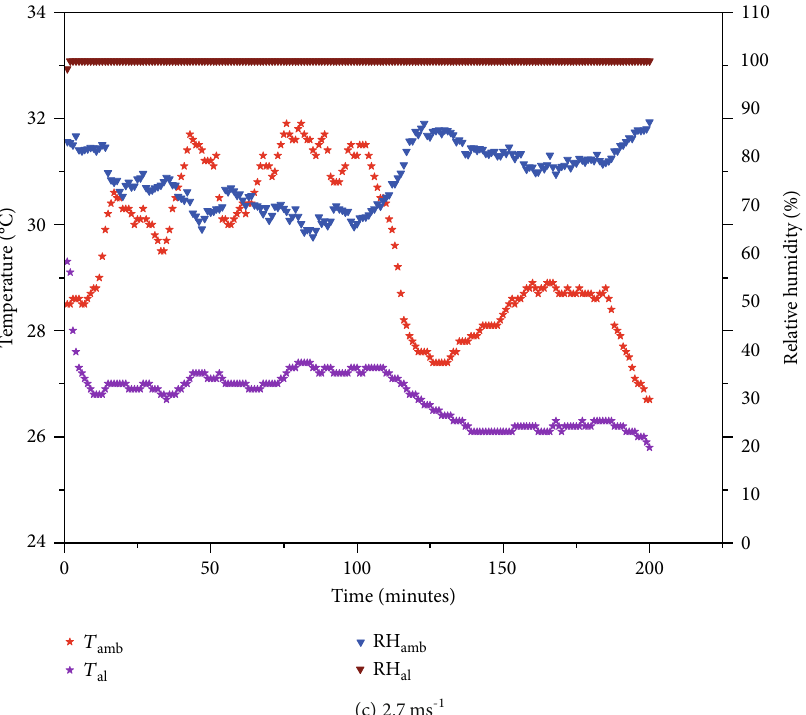
Figure 7: Temperature and RH variations of the air from the air cooler at three di ff erent velocities under high RH